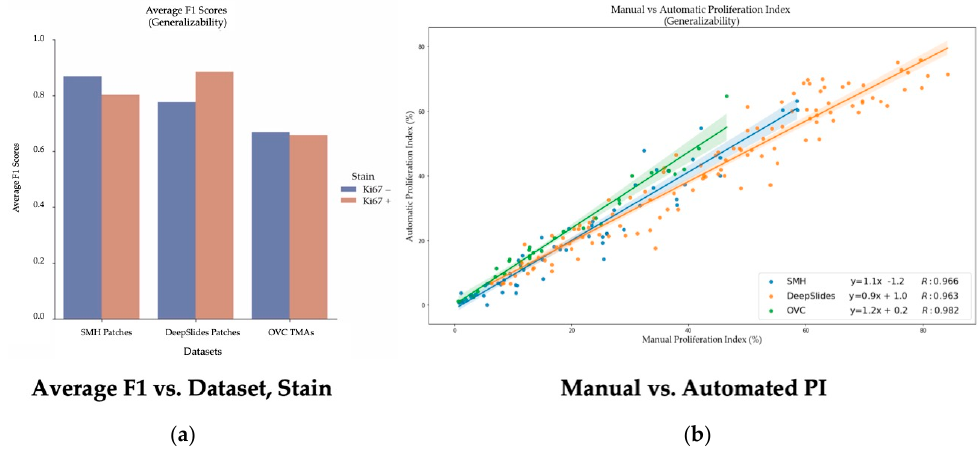
Figure 15. ( a ) Average F1 scores and ( b ) Manual vs. Automatic PI on three datasets: SMH Patches, DeepSlides and OVC TMAs. Table 6. Average F1 scores and accuracy rates across three datasets of individually annotated